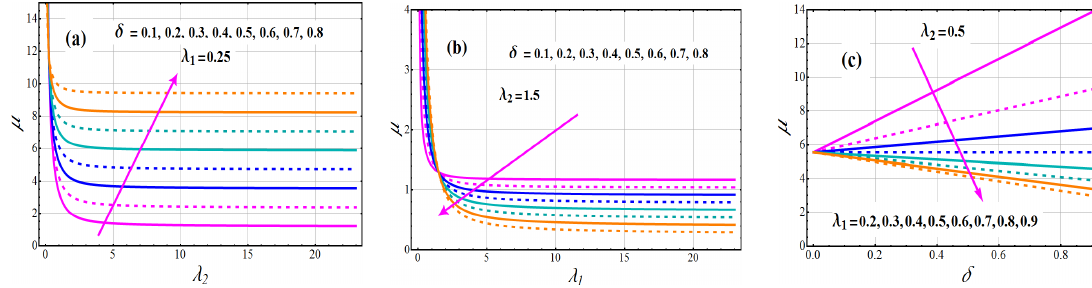
Fig. 3. Variations of Mean of TC-MAM. Figure 3. Variations of Mean of TC-MAM.